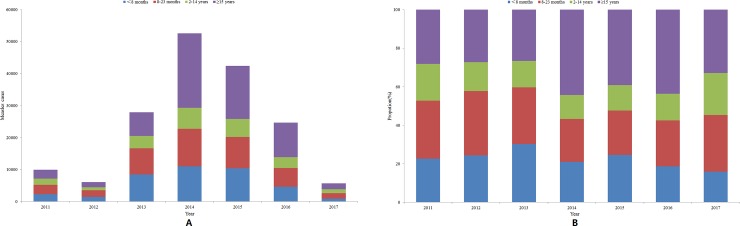
Measles cases in different age groups in China from 2011 to 2017.A: The number of measles cases in different age groups. B: The proportion of different age groups of measles cases. Source: NNDRS.